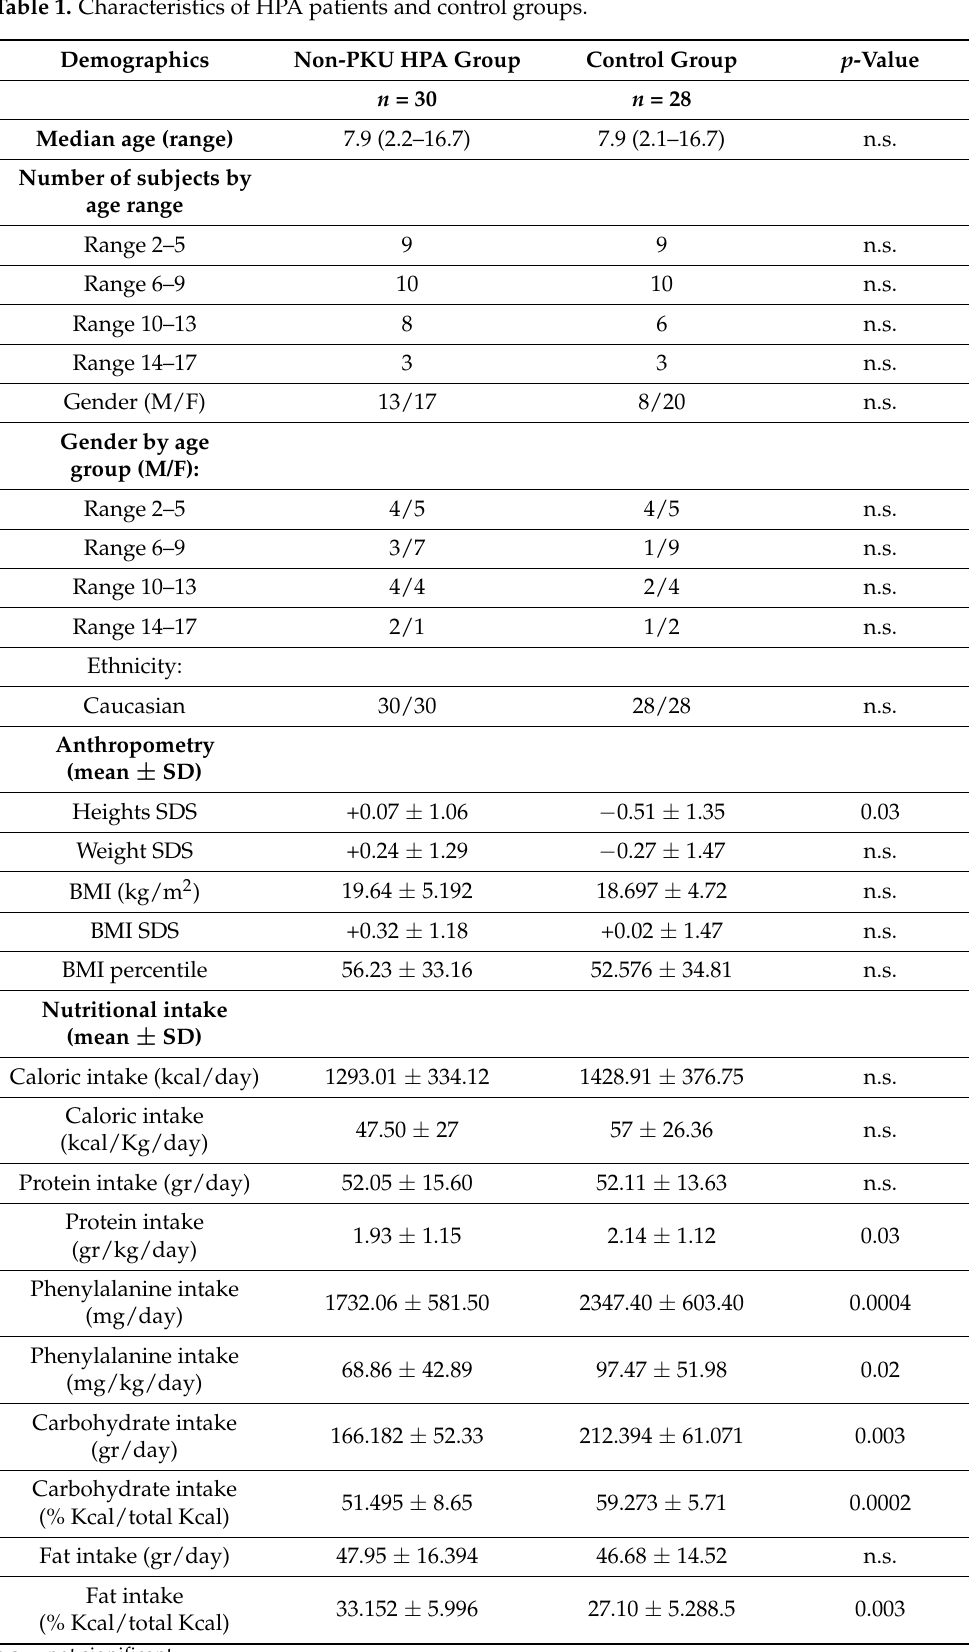
Table 1. Characteristics of HPA patients and control